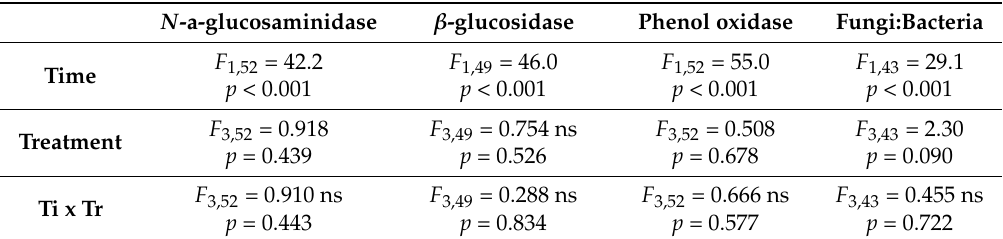
Figure 2. ( a ) N -acetyl-glucosaminidase activity, ( b ) β -glucosidase activity, ( c ) phenol oxidase activity, ( d ) fungal:bacterial ratio of bird’s nest ferns at 0, 3, 6 months (Mean ± s.e., n = 5). Treatments are indicated in the legend as follows: AN = ammonium nitrate; W = worms; C = control; AN + W = ammonium nitrate plus worms. Table 2. Two-way ANOVA results of time and treatment on enzyme activities and fungal:bacterial ratios in soil associated with bird’s nest ferns.